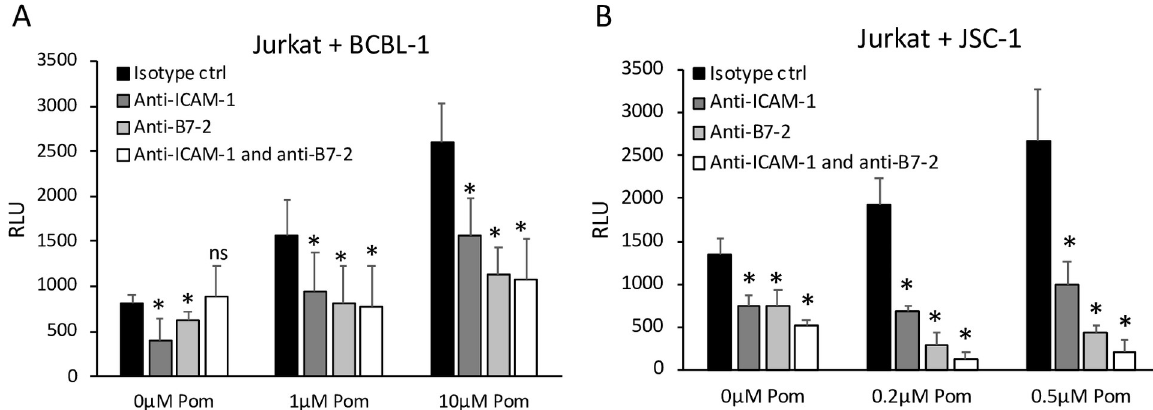
Fig 2. Blocking of ICAM-1 and/or B7-2 prevents Pom-induced increases in T-cell activation. PEL cells grown for 48 hours in the presence of DMSO ctrl (0 μ M Pom) or indicated concentrations of Pom were treated with anti-ICAM-1 Ab, anti-B7-2 Ab, both anti-ICAM-1 and anti-B7-2 antibodies, or appropriate isotype control (IgG1 for anti-ICAM-1 Ab and IgG2 for anti-B7-2 Ab), at a 10ug/mL final concentration each for 30 minutes and then co-incubated for 6 hours with IL2-Jurkat T-cells in the presence of 2.5 μ g/mL anti CD3 antibody. Results indicate average RLU from IL2-Jurkat cells coincubated with BCBL-1 (A) or JSC-1 (B) cells and error bars represent standard deviation from 3 independent experiments. Statistically significant differences ( � p � 0.05, ns not significant paired 2-tailed t -test) are indicated.